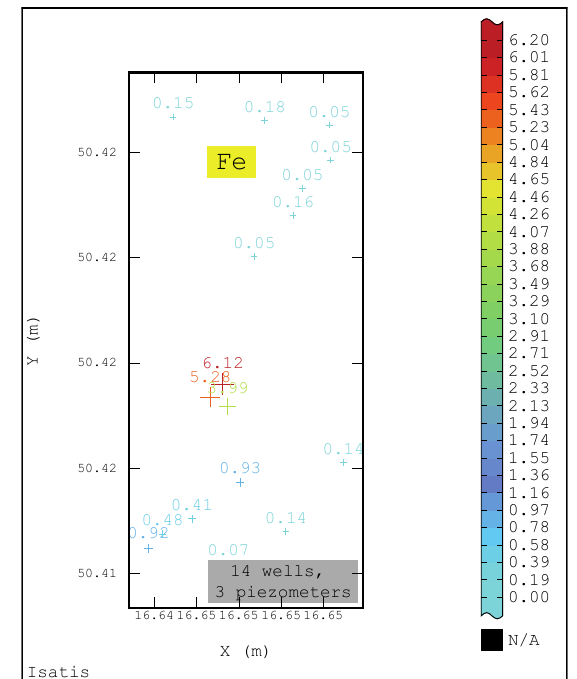
Fig. 2a. Base map of iron Fe ++ [g Fe ++ /m 3 ] content in underground water for water intake area of Kłodzko (SW part of Poland); data coming from 14 wells + 3 piezometers